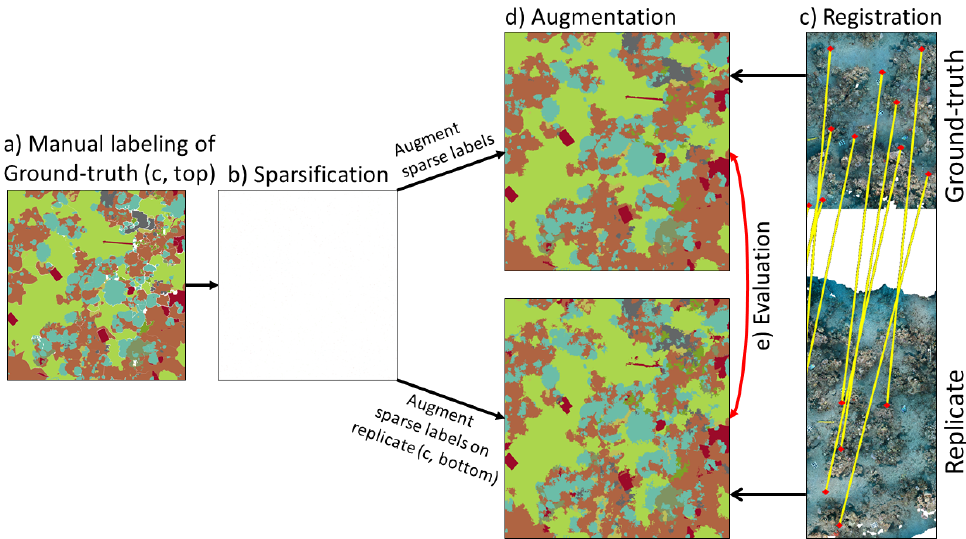
Figure 6. Testing orthorectification through label-augmentation. Two photomosaics are generated subsequently, the ground-truth (top) represents the baseline survey, and the replicate (bottom) represents the temporal repeat. ( a ) The ground-truth (baseline) photomosaic is labeled. ( b ) Labels are sparsified ( c ) Manual registration of photomosaics is done using distinctive features in the scene. ( d ) Sparse labels from ( b ) are augmented on the baseline and transformed mosaic replicate. ( e ) augmented maps are used for